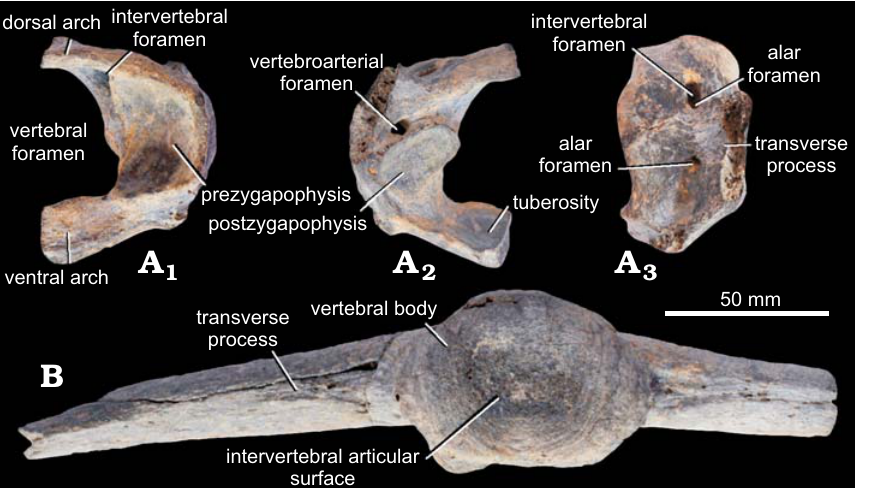
figure with its major axis transverse to the carapace sur- rounded by a row of foramina. The lateral and posterior ar- ticular surfaces are perpendicular. Two obliquely oriented, posterior articular surfaces form a vertex pointing posteri- orly. The ventral surface is flat or slightly concave.